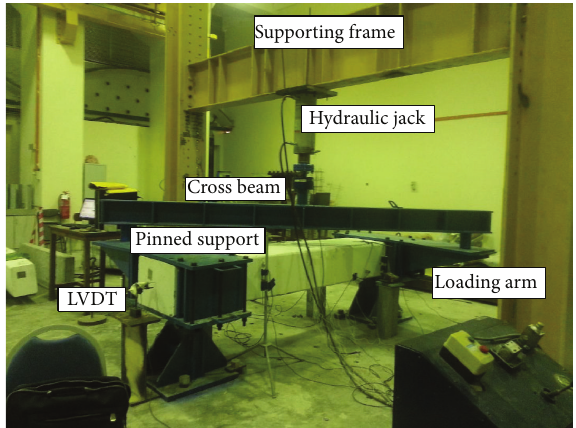
Figure 3: Test machine setup and instruments.